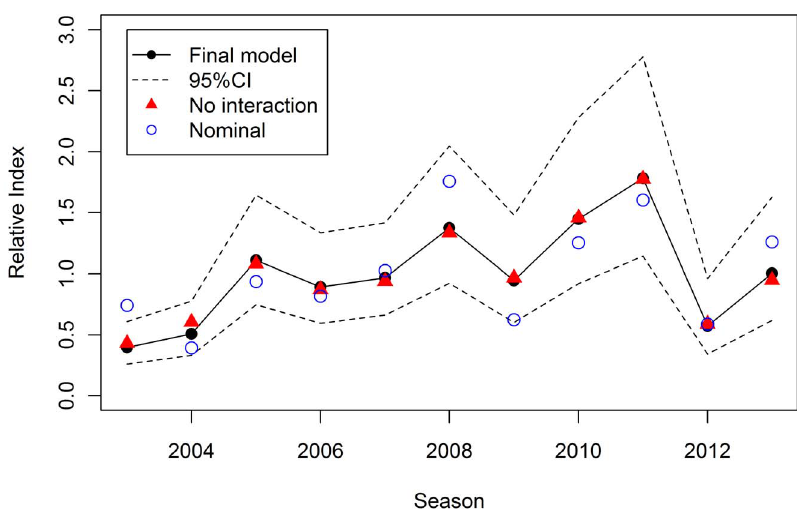
Fig. 4. The standardised annual index of relative juvenile abundance from the final model with interactions. The index derived from the final model scaled to the mean with approximate 95% confidence interval. Also shown are index values (but not uncertainty) for a model with no interaction terms and the nominal (i.e. unstandardised) index.